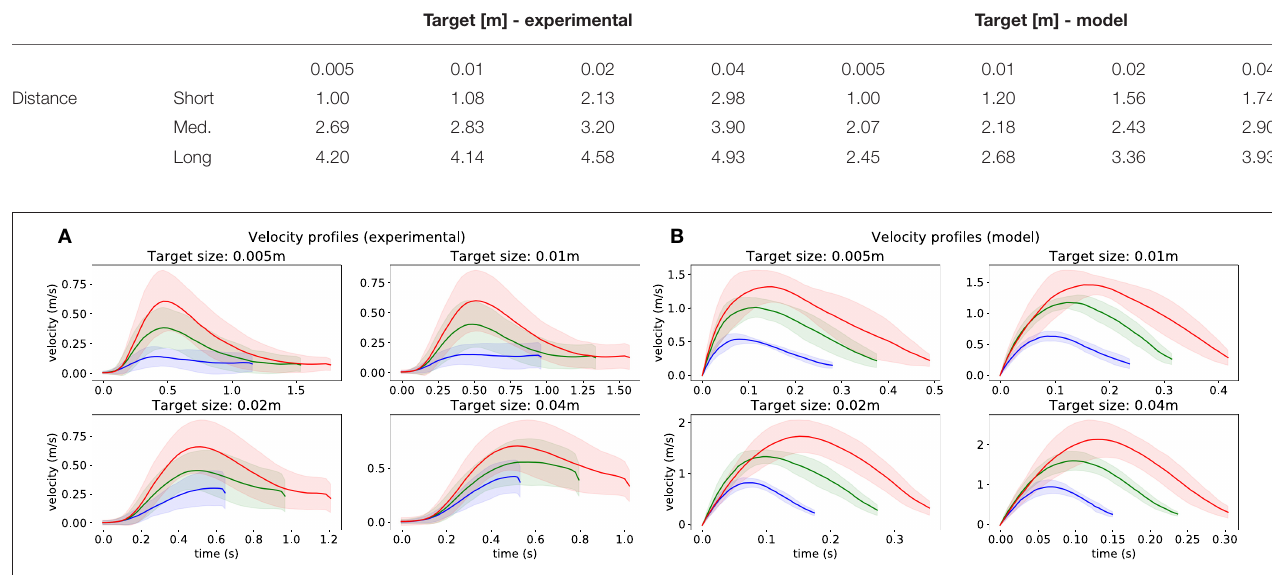
TABLE 1 | Peak velocity relationship to target size and distance (normalized to the first value).